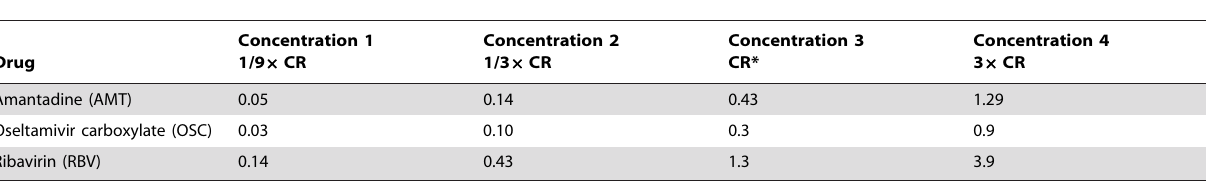
Table 2. Concentrations ( m g/mL) of Drugs Used for Serial Passage at Fixed Concentrations.